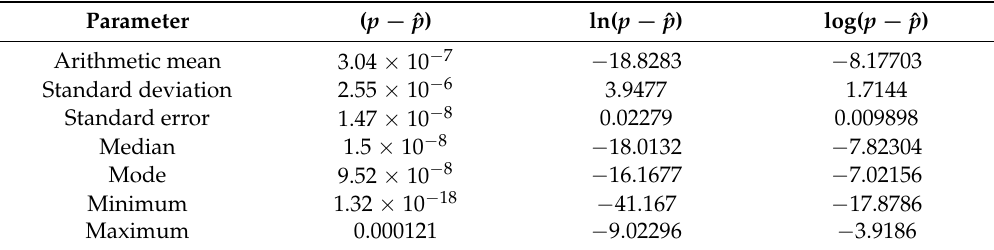
Table 8. Residuals: descriptive statistics.